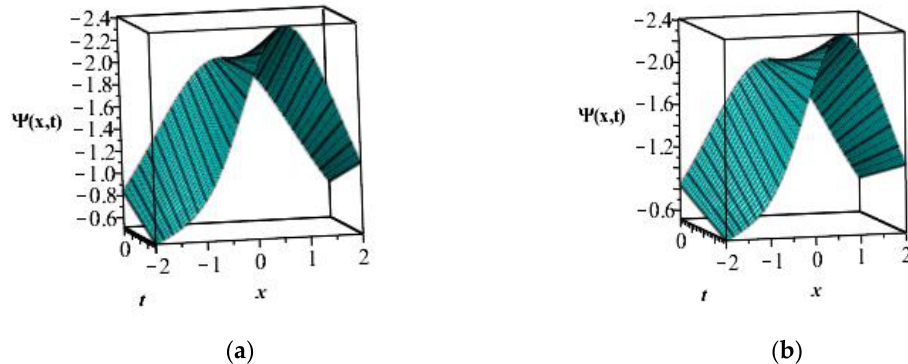
Figure 6. Comparison plots of